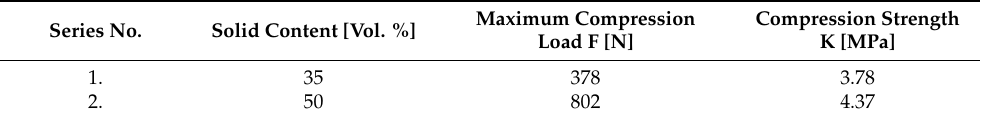
Figure 10. Stress–displacement graph of the composites: orange line—Series containing 35 vol.% solid phase (Series I); blue line—Series containing 50 vol.% solid phase (Series II). Table 3. Monotonic compression test